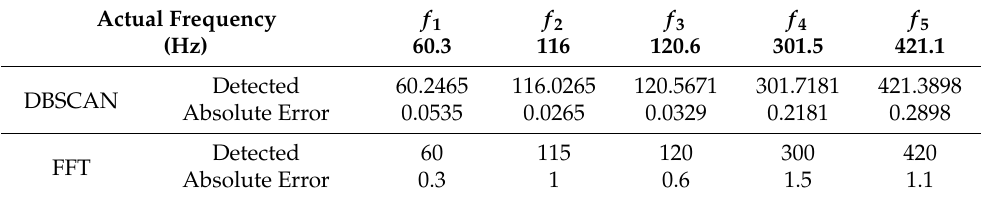
Table 2. Performance of frequency estimation of the proposed method.